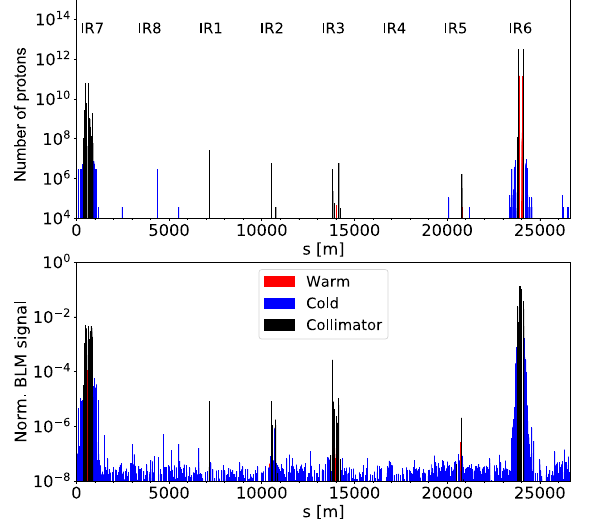
FIG. 12. Simulated (top) and measured (bottom) loss map for an ABDF test with colliding beams during the 2018 208 Pb 82 þ ion run commissioning.